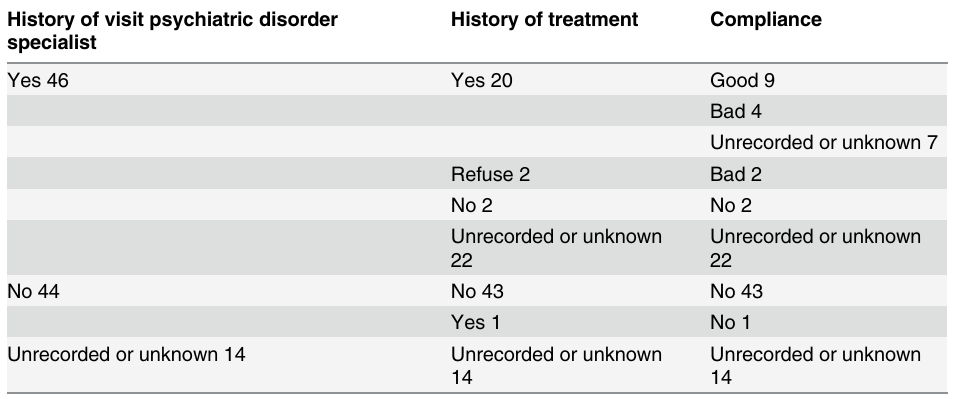
Table 7. History of visit psychiatric disorder specialist, treatment and compliance.